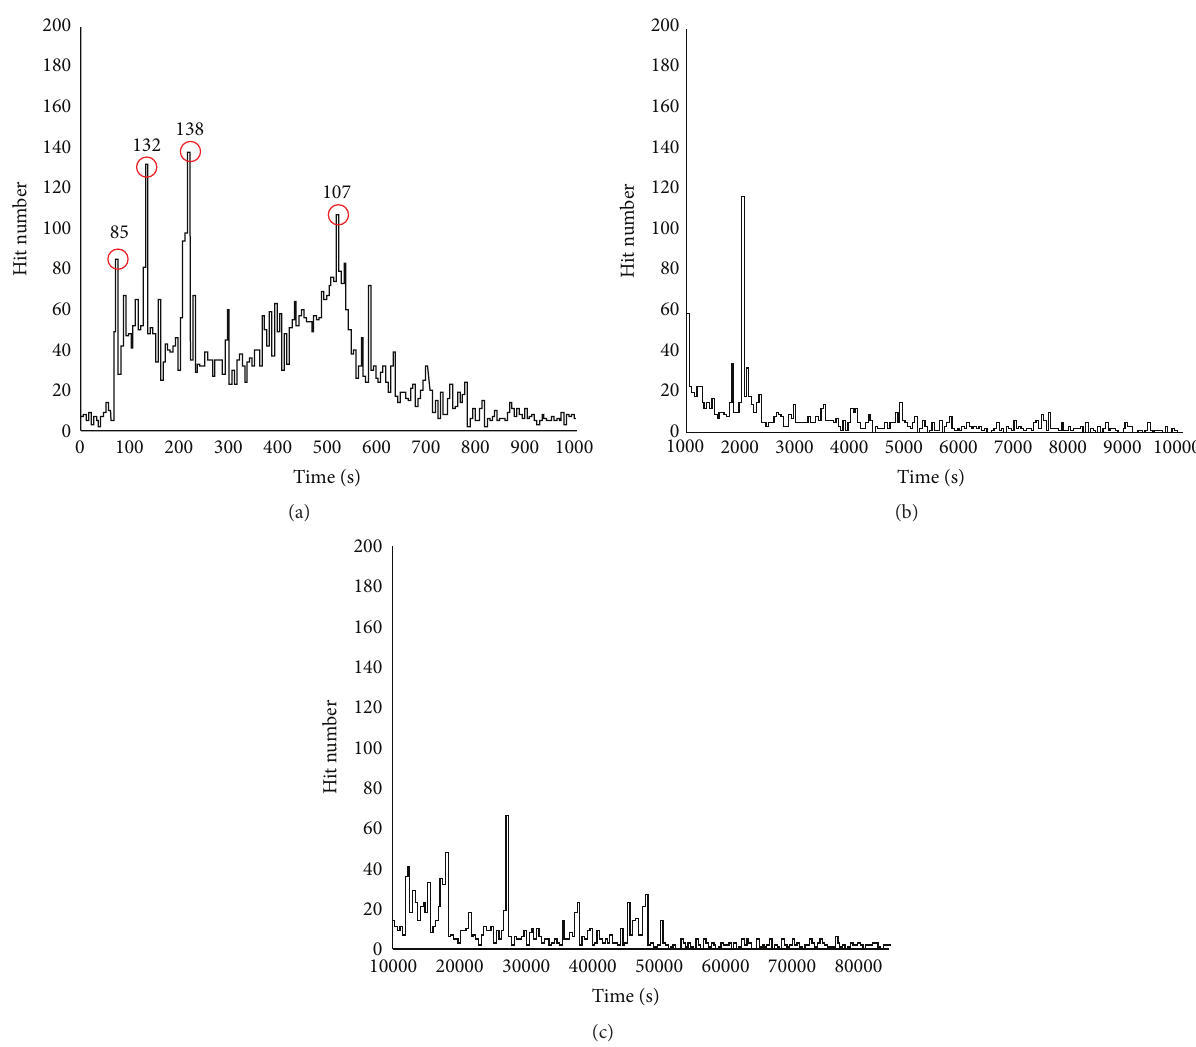
Figure 3: Change of AE hit number with the tensile loading time: (a) 0s–1000 s; (b) 1000 s–10000s; (c) 10000